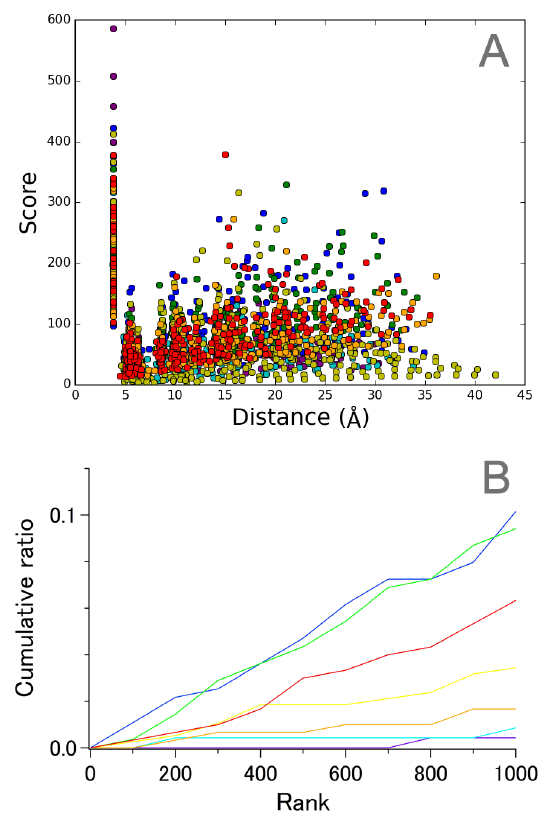
Figure 3. DSA results for 1,992 intrahelical pairs in set 1. A . Correlation between score and average distance. B . Cumulative ratio of the number of C −C pairs in the top-ranked 1,000. The pairs α α are colored as follows; purple, helix A; blue, helix B; cyan, helix C; green, helix D; yellow, helix E; orange, helix F; red, helix G.